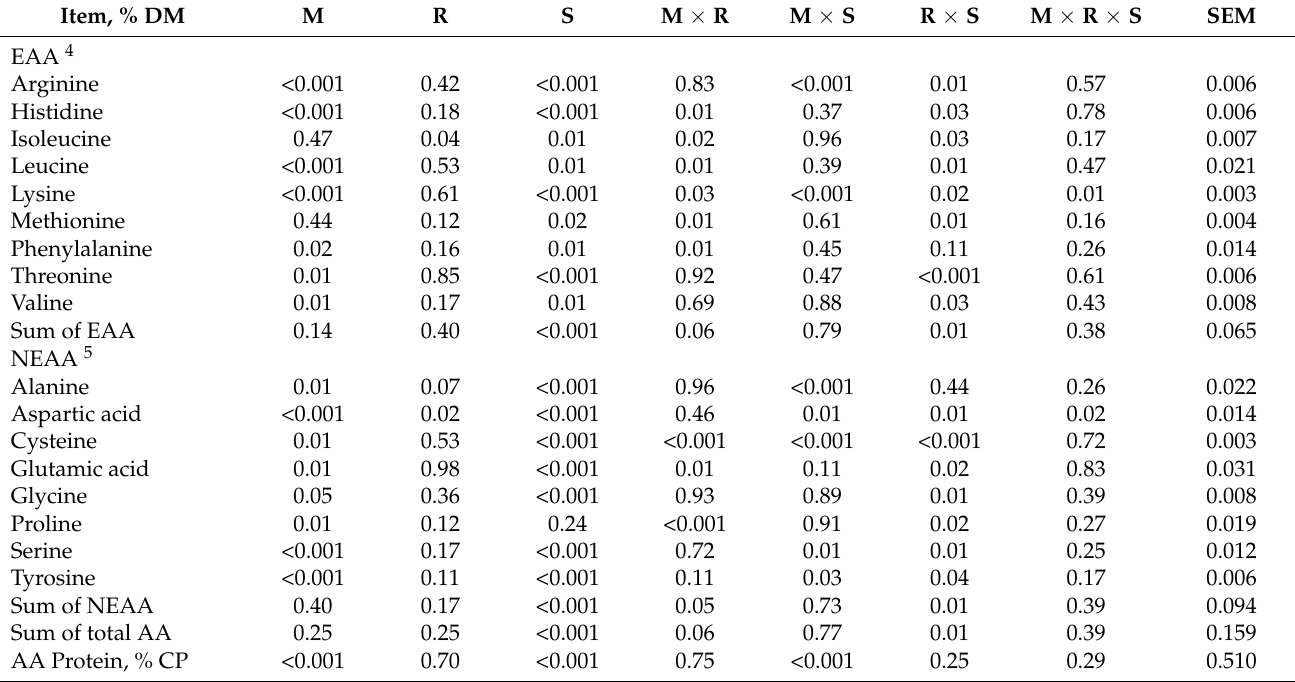
Table 5. Statistical analysis ( p -values) for the effect of maturity 1 (M), roll gap width 2 (R), storage length 3 (S), and their interactions on the amino acid profile of whole-plant maize silage. (Total n =